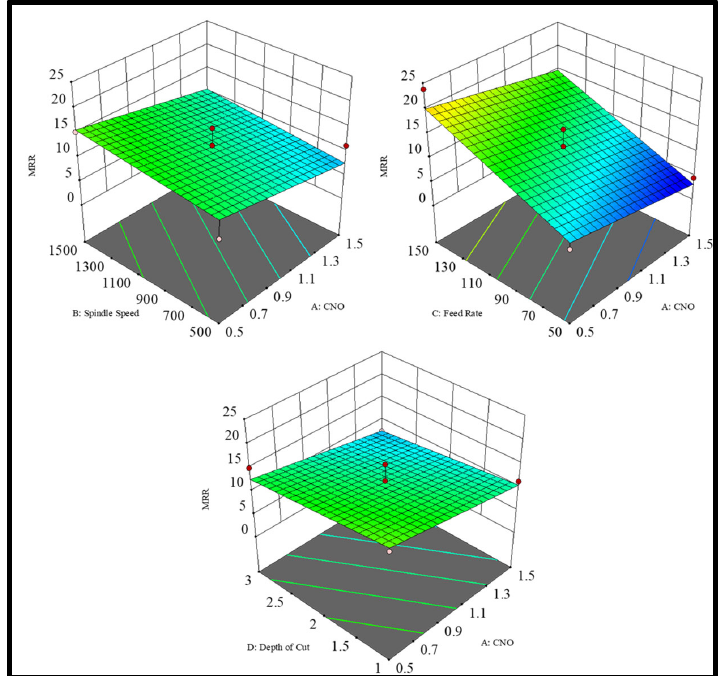
Fig. 9. 3D Plot for MRR